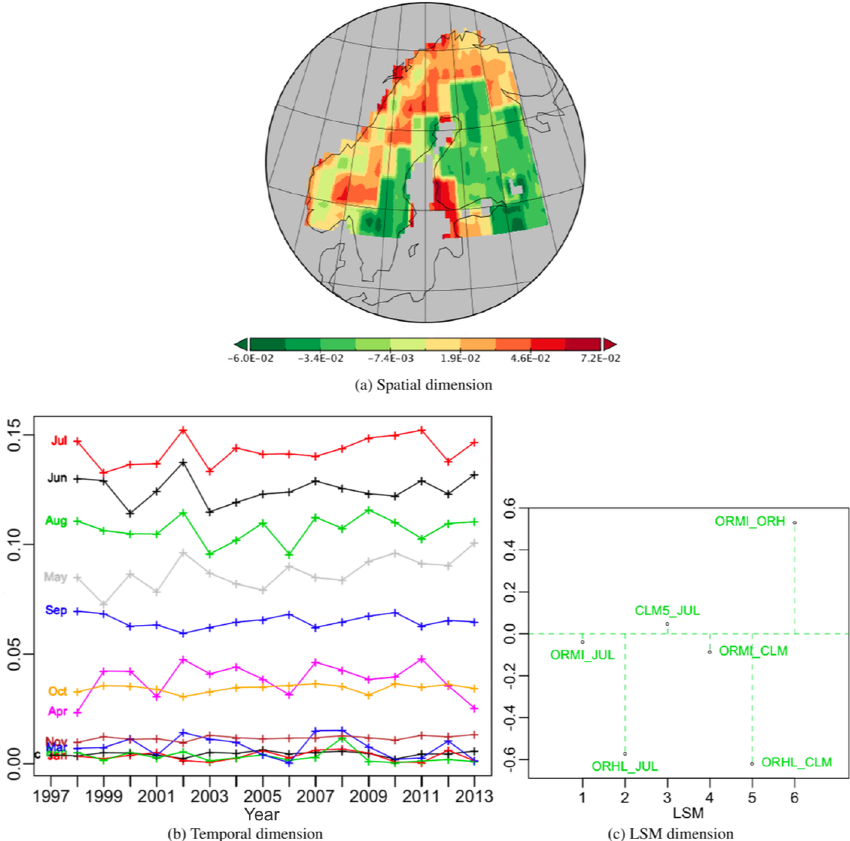
Figure 9. Best PT ( vs111 ) of the PTA3 decomposition of the six normalized differences, representing 43.37% of the variability. In (c) , the labelling CLM5_JUL indicates the difference CLM5-JULES, and similarly for other LSM